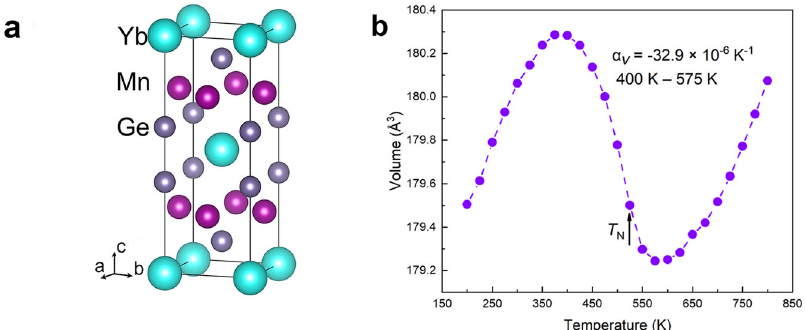
Fig. 1 Crystal structure and thermal expansion characteristics. a Crystal structure of YbMn 2 Ge 2 , and b temperature dependence of the unit cell volume.